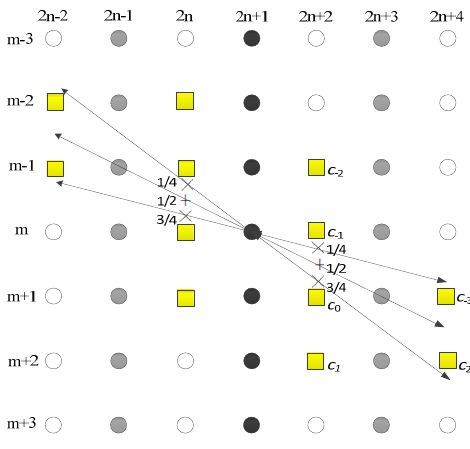
Figure 5. The process of directional interpolation.